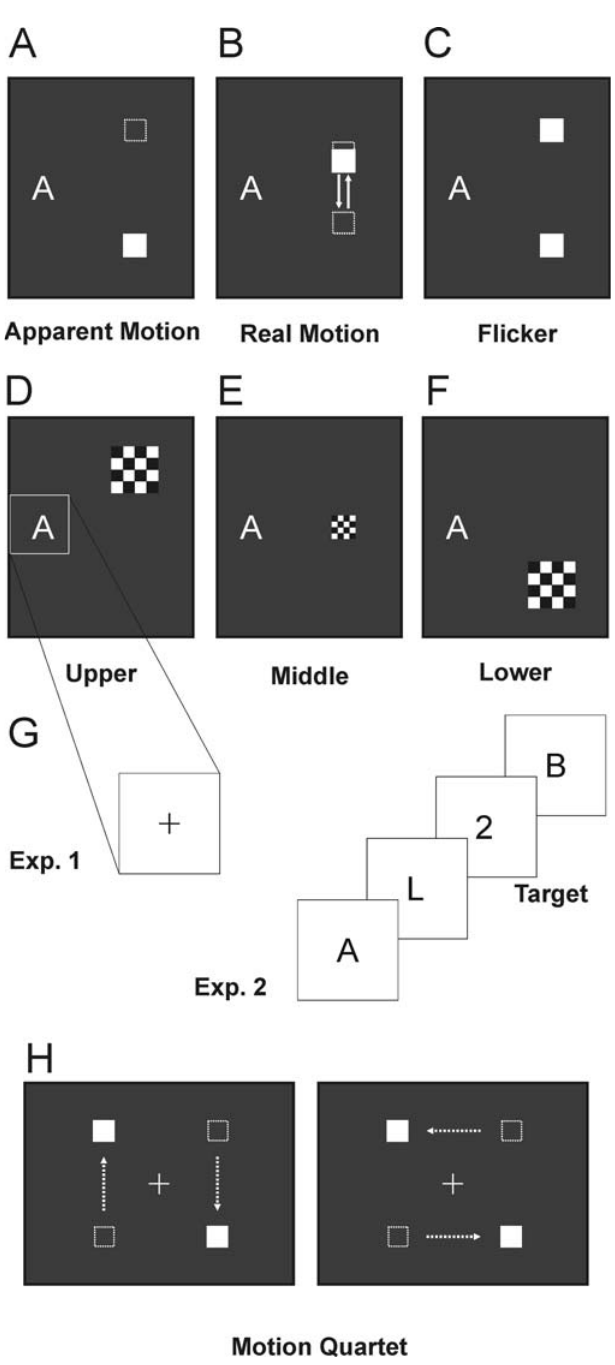
Figure 1. Stimuli Used in Experiments 1 to 3 (A) The apparent-motion stimulus consisted of two white squares (size, 1.8 8 ) blinking in alternation (2.3 Hz). The squares were presented at an eccentricity of 9.5 8 visual angle (distance between squares, 16.5 8 ). (B) The real-motion stimulus consisted of a white square moving in (cid:1) 1 ) on the perceived path harmonious oscillation (average speed, 66.5 8 s of apparent motion. The end points of the movement were adjacent to the position of the apparent-motion squares (maximum eccentricity, 8.0 8 ). (C) The flicker control stimulus from experiment 2 was composed of two white squares (1.8 8 ) that were blinking simultaneously at 4.6 Hz. (D–F) For the mapping conditions, high-contrast inverting checkerboards were presented in the upper (D), middle (E), and lower (F) right visual field. Sizes were adjusted according to the cortical magnification factor in V1 to produce activated regions of a similar spatial extent (3.6 8 for